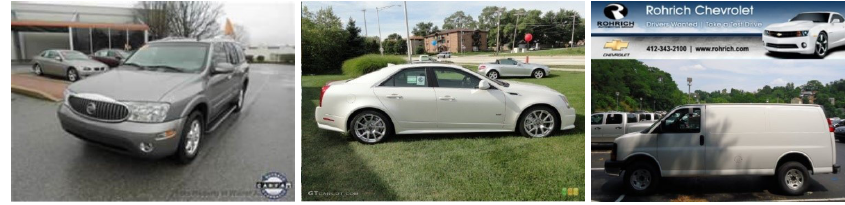
Figure 2. Stanford car dataset image noise examples